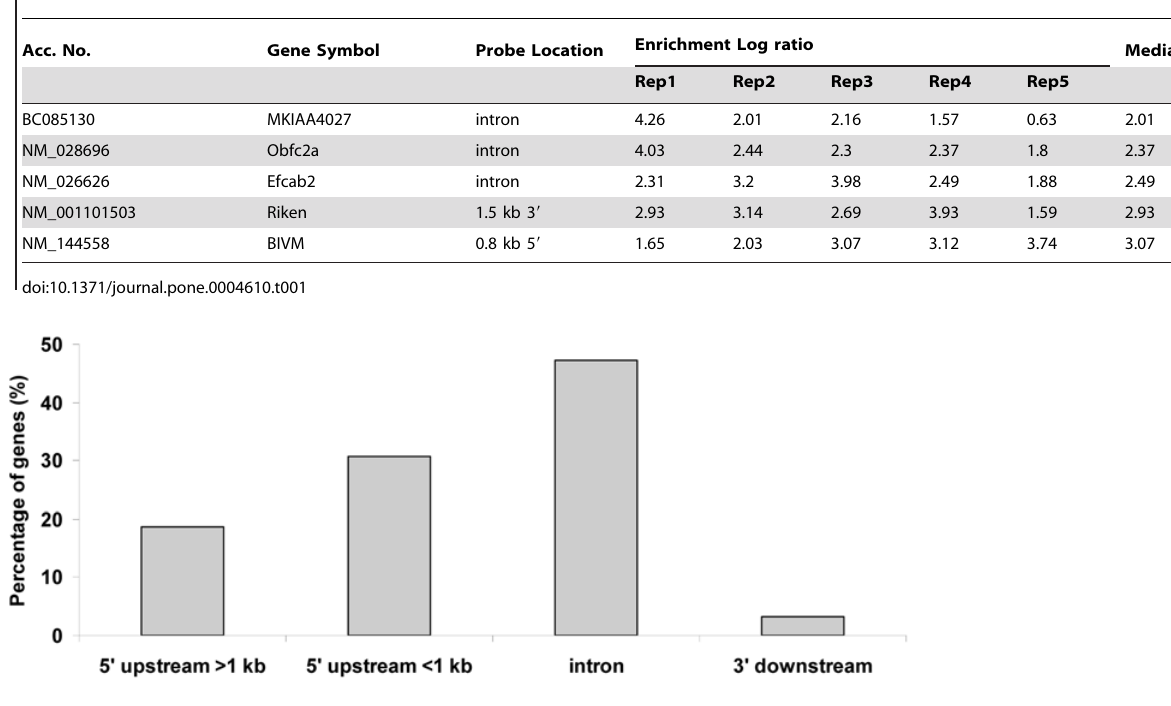
Figure 2. Distribution of genomic locations of binding sites of 91 genes. The mid point of each probe was used to calculate the distance to the closest gene.